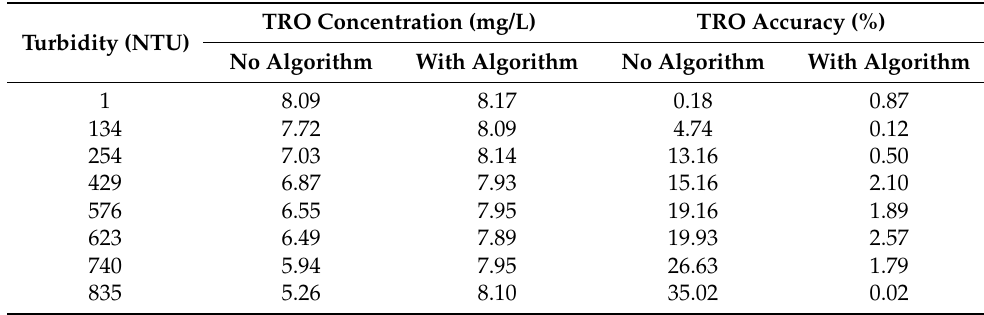
Table A3. TRO concentration and accuracy by turbidity with or without the proposed algorithm